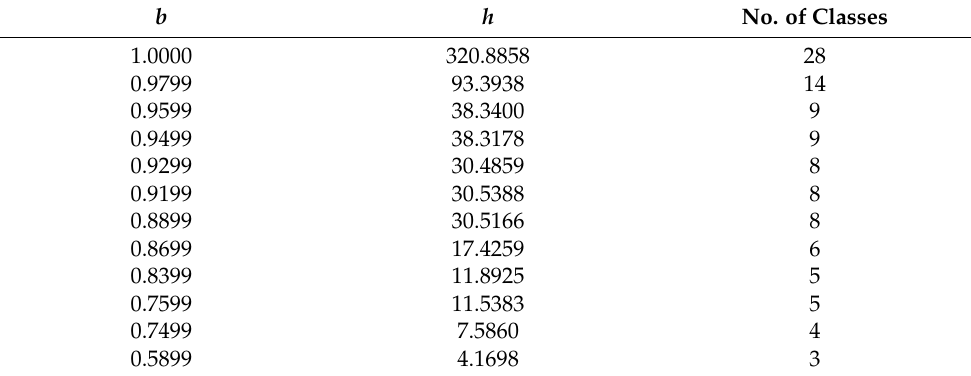
Table 3. Entropy and classification level b for different numbers of classes.